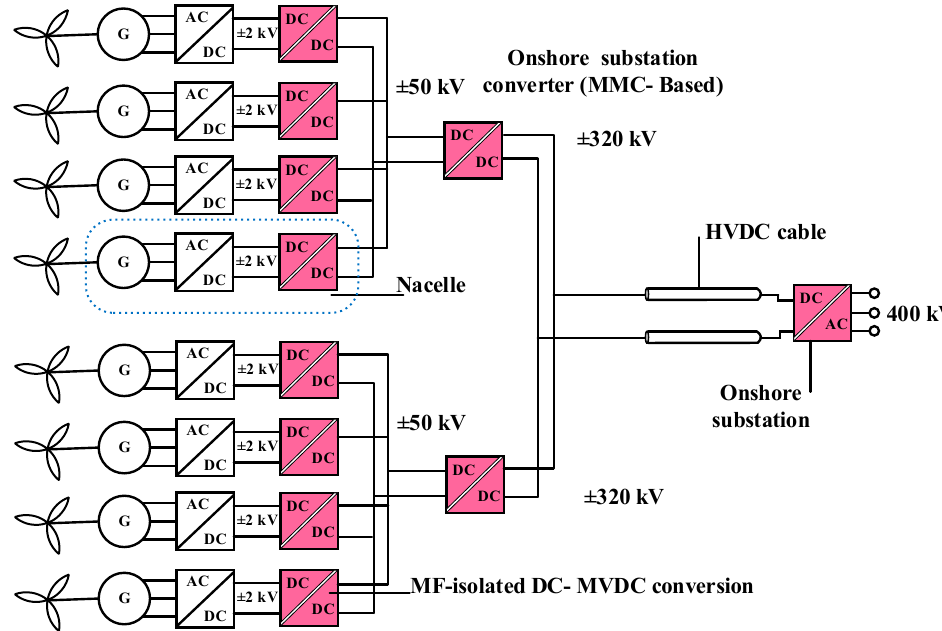
Figure 9. Offshore wind farm DC collection grid.